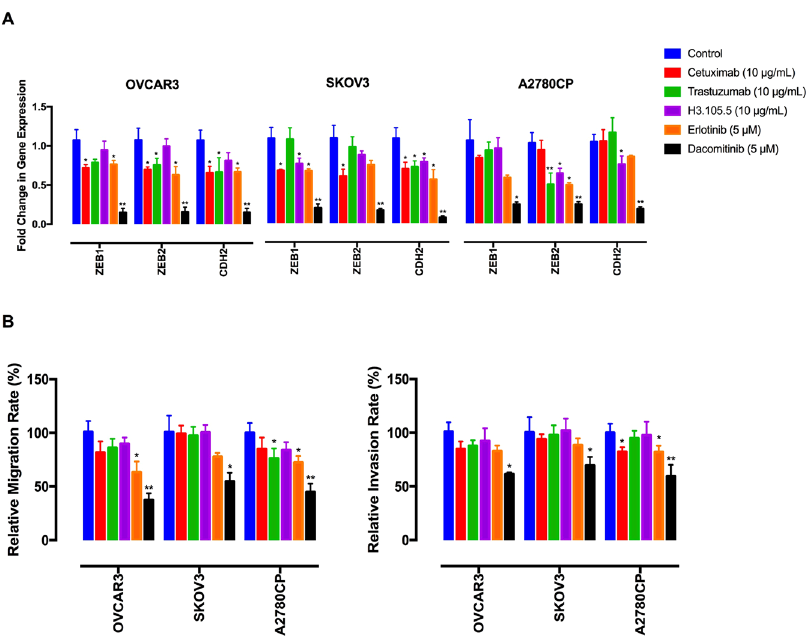
Figure 5. Dacomitinib inhibits migration and invasion. ( A ) The effects of the anti-ErbB agents on expression of EMT markers were determined by qRT-PCR analysis. ( B ) The effects of the ErbB inhibitors on cell migration and invasion. The cells were placed into 8- μ m porous culture inserts, treated with the drugs and allowed to migrate for 48 h. The migrated cells on the lower surface of the inserts were quantified by crystal violet staining. For invasion assay, the cells were placed into matrigel-coated inserts and allowed to invade through the matrigel layer for 48 h. Data shown represent the mean ± SD from three independent experiments, each performed in triplicate. Statistically significant values of * p < 0.05 and ** p < 0.01 were determined compared with the